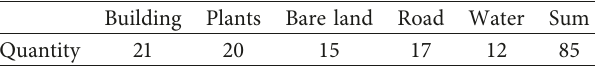
Table 1: Sample classification statistics of image A.